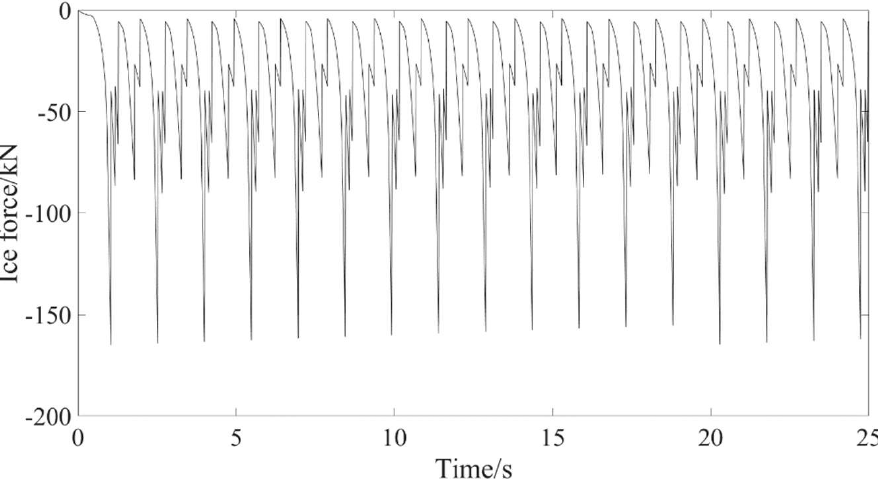
Figure 8. Time history curves of total ice force in case 2.